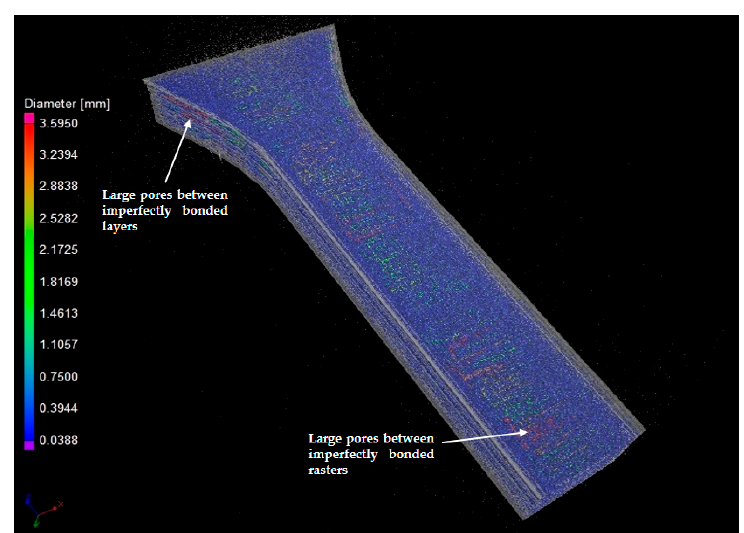
Figure 6. Three-dimensional visualization of pore distribution for UPL = 3.6 mm. Representative large pores between the imperfectly bonded layers and rasters are highlighted.